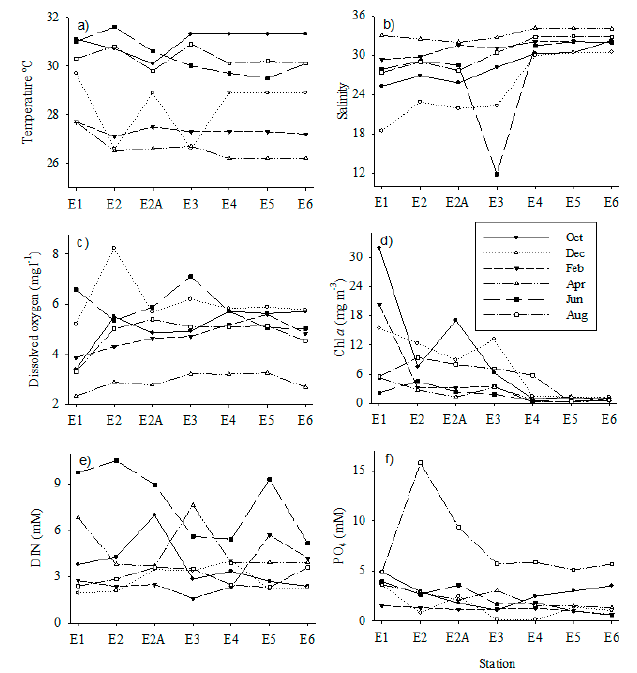
Figure 3. Temperature ( a ), salinity ( b ), dissolved oxygen ( c ), chlorophyll-a ( d ), dissolved inorganic nitrogen (nitrates, nitrites, and ammonium) ( e ), and phosphate concentration ( f ) values for surface water in the Juluapan lagoon.